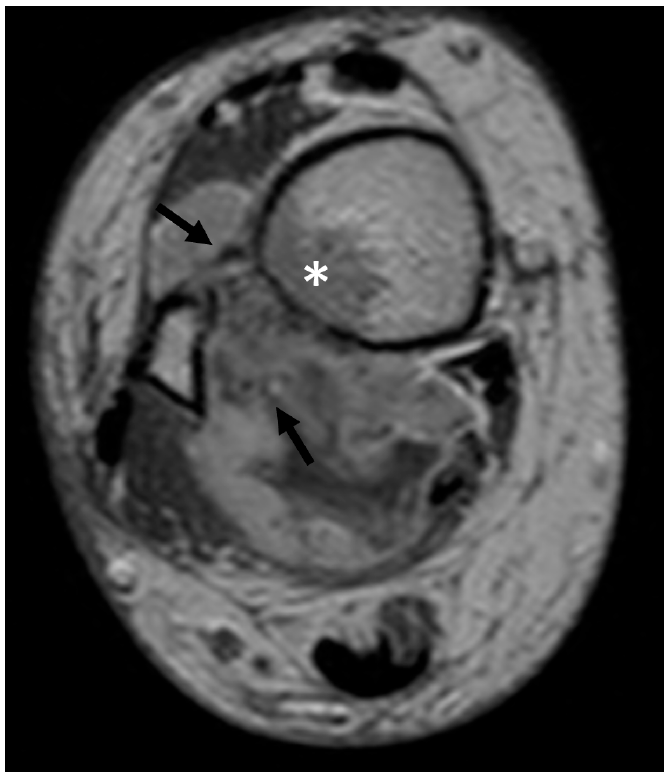
Figure 1. Axial MRI of an Undifferentiated Pleomorphic Sarcoma of the right lower leg